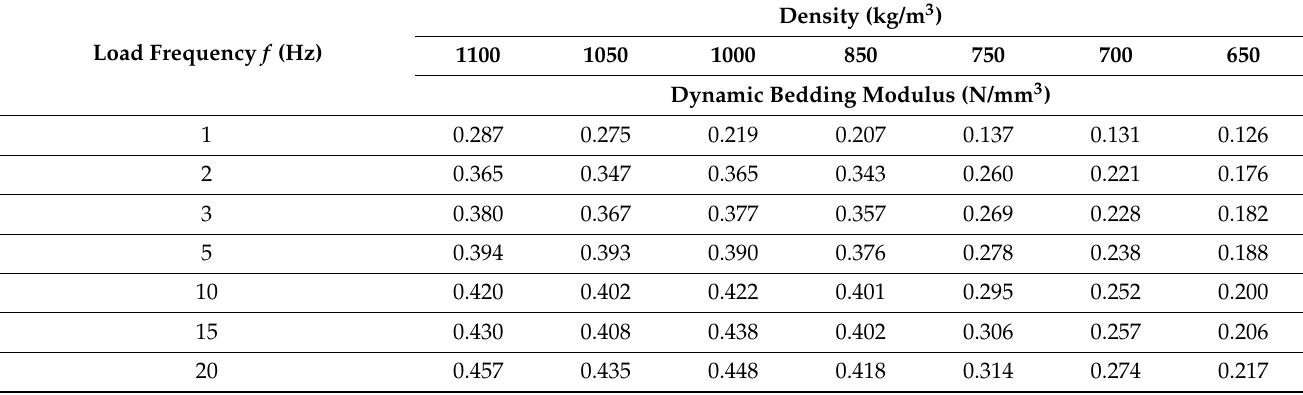
Load Frequency f